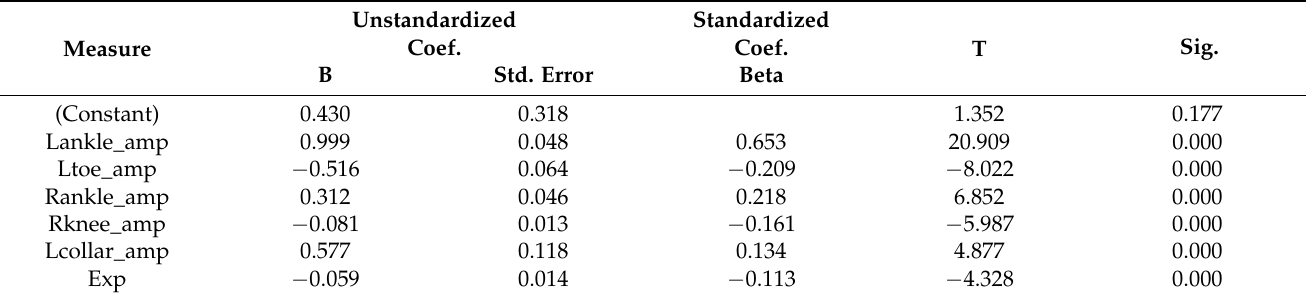
Table 11. Results of Stepwise Regression of SD_hip (Amp.